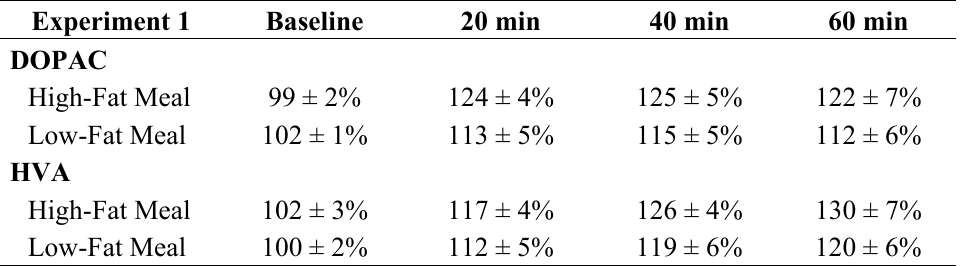
Table 1. Percentages of baseline measurements of 3,4-dihydroxyphenylacetic acid (DOPAC) and homovanillic acid (HVA) according to time and